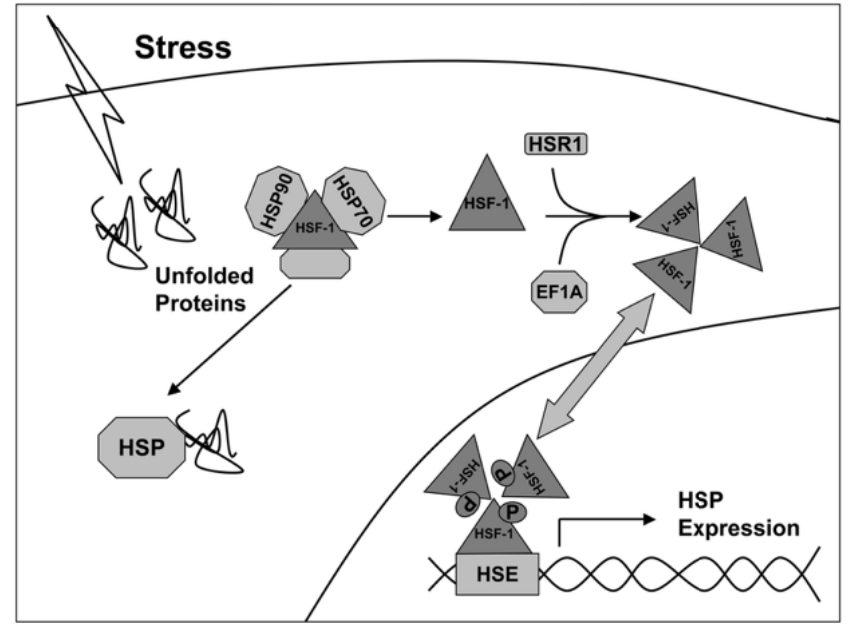
Figure 1. Activation scheme of HSP gene expression under stress conditions [17].